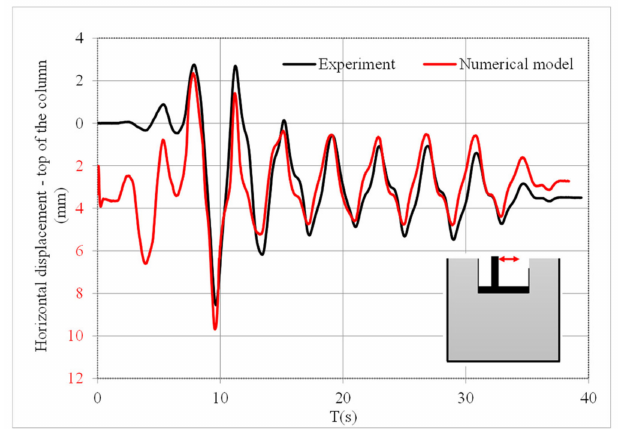
Figure 6. Horizontal displacement time history of the top of the